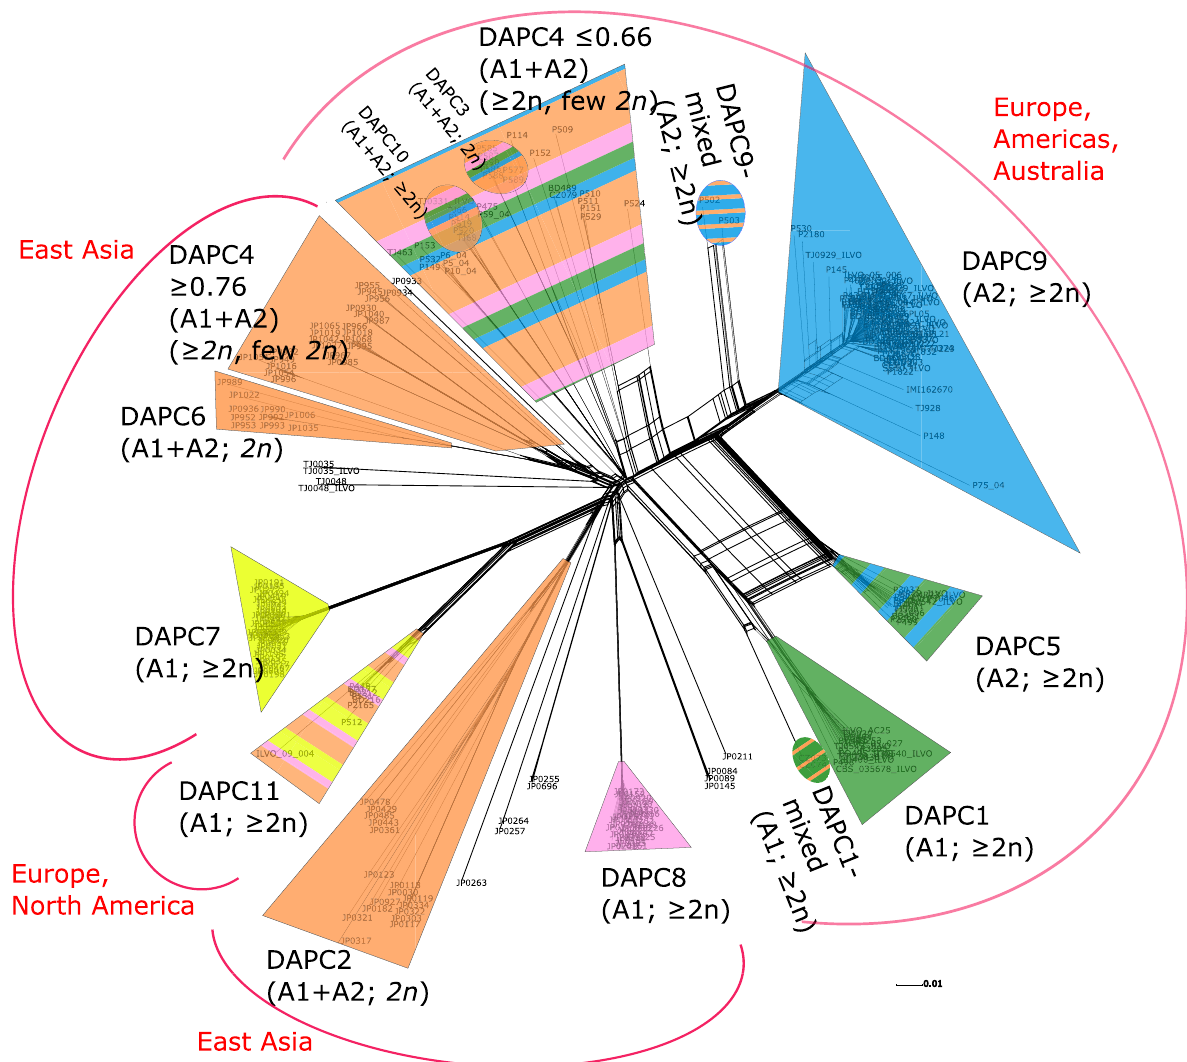
Fig. 4 Splitstree network of the P. cambivora -related isolates constructed with the equal angle algorithm using uncorrected p-distances. DAPC × groups are outlined and coloured by their STRU CTU RE membership probabilities. In parentheses below the DAPC group label are the mating type and ploidy level of the